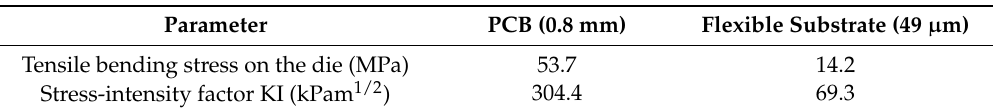
Table 4. Comparison between PCB and flexible on board-level thermo-mechanical reliability (die thickness = 0.5 mm, ∆ T = 100 ◦ C).